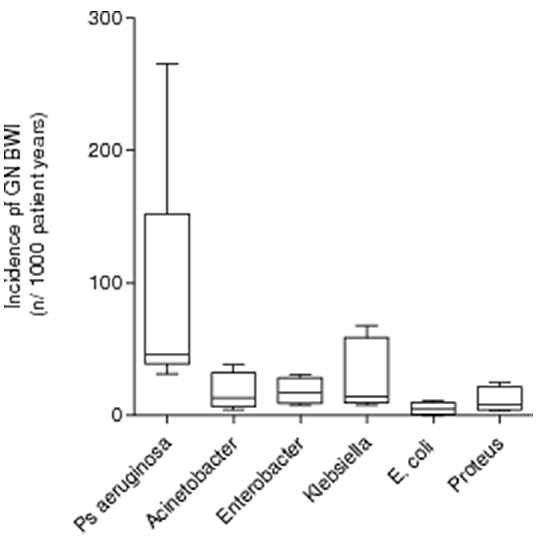
Figure 2. Box-whisker plot reporting data dispersion for the standardised incidence of Gram-negative burn wound injury in civilian adult hospitalised patients. Data shown represents mean 6